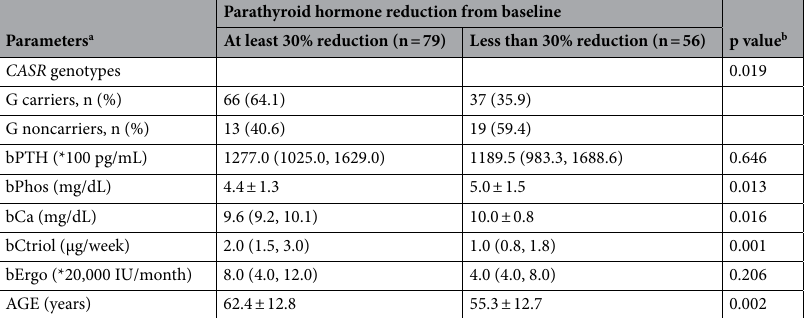
Table 4. Characteristics of patients in groups classified by the achievement of at least 30% parathyroid hormone reduction form baseline after 12 weeks of cinacalcet treatment (n = 135). AGE age on the day of baseline serum phosphate concentration, bPTH baseline serum intact parathyroid hormone concentration. a Continuous data are expressed with either means ± standard deviations if they are normally distributed or medians (interquartile ranges) if they are not normally distributed. b The p values were calculated with the use of the chi-square test, the Mann–Whitney U test, or the t-test for comparison between G carriers and noncarriers.